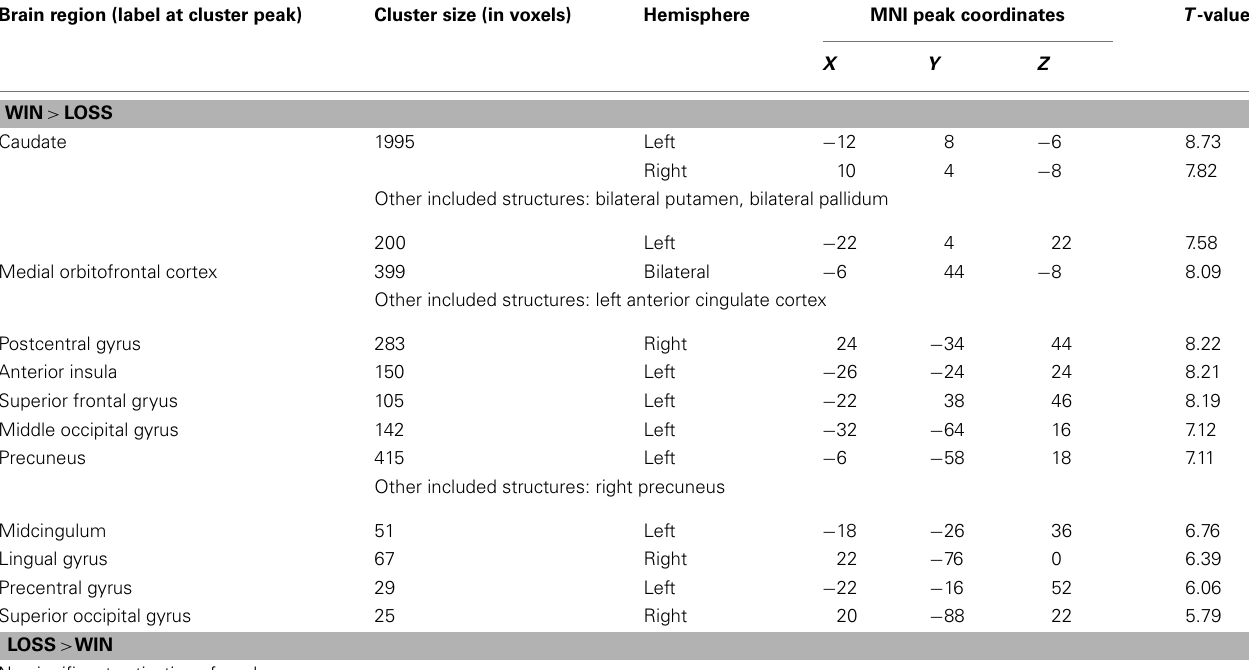
TableA4 | Neural correlates during feedback (whole-brain analysis, FWE-corrected, P < 0.05, k = 10). Brain region (label at cluster peak)